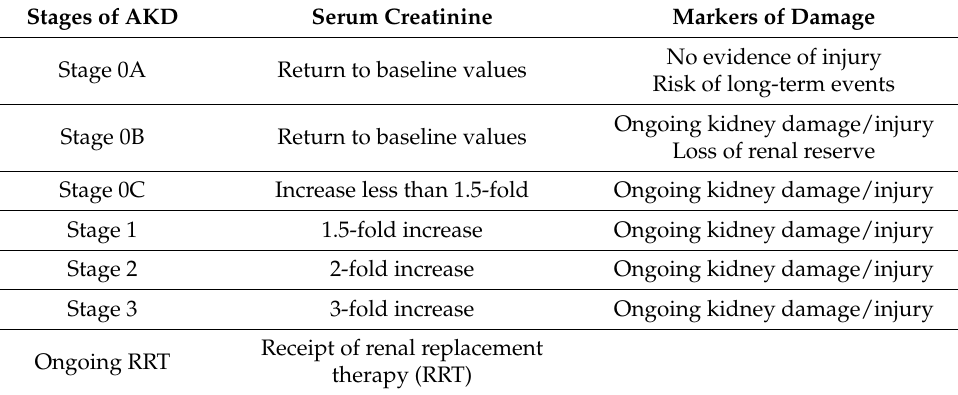
Table 2. Stages of AKD according to Acute Disease Quality Initiative (ADQI) consensus